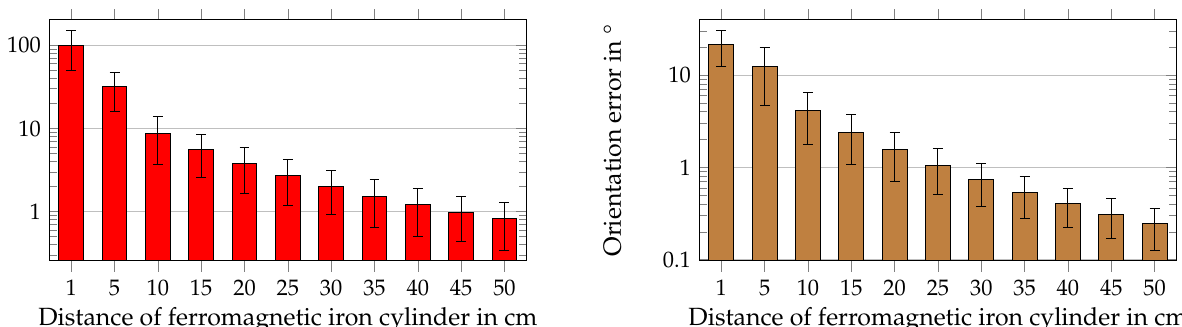
Figure 12. Position and orientation errors for different distances from the localization system to an iron cylinder. For a distance below 10 cm, the mean position error was up to 100 mm, whereas it was around 1 mm for a distance of 40 cm. Moreover, for a distance higher than 5 cm, the slope of the position error was significantly reduced and started to flatten for a distance higher than 30 cm. The orientation error was up to approximately 20° for a distance smaller than 5 cm. At distances higher than 25 cm, the orientation error was smaller than 1°. The observed curve flattening of the position error was less severe for the orientation error. Overall, the position and orientation errors significantly decreased with the